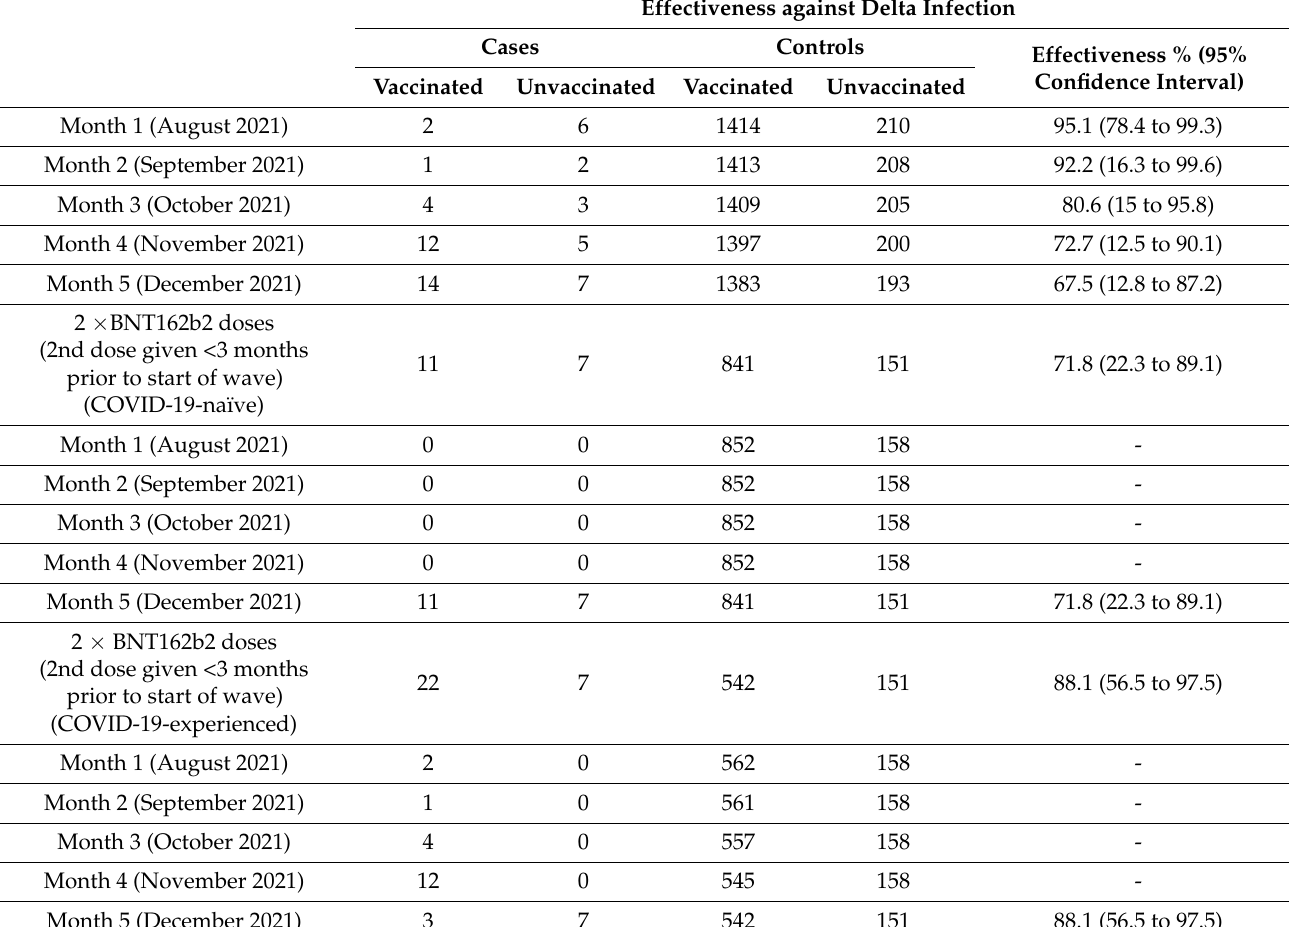
Table 1. Cont. Effectiveness against Delta Infection Cases Controls Effectiveness % (95%